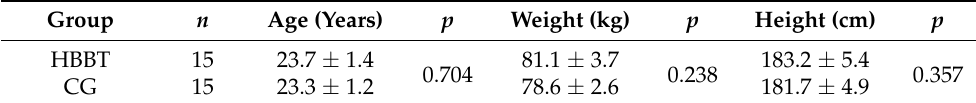
Table 1. Demographic characteristics of subjects in each